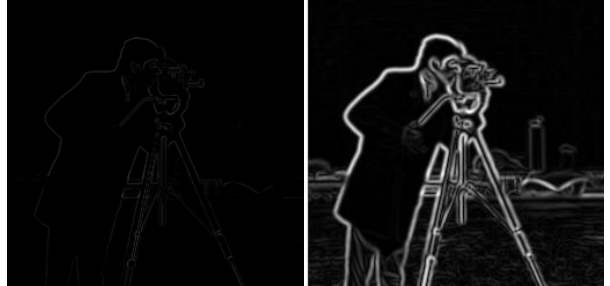
Figure 5. Magnitude matrix of Sobel (left) and Canny (right) to be used for initial pheromone value.